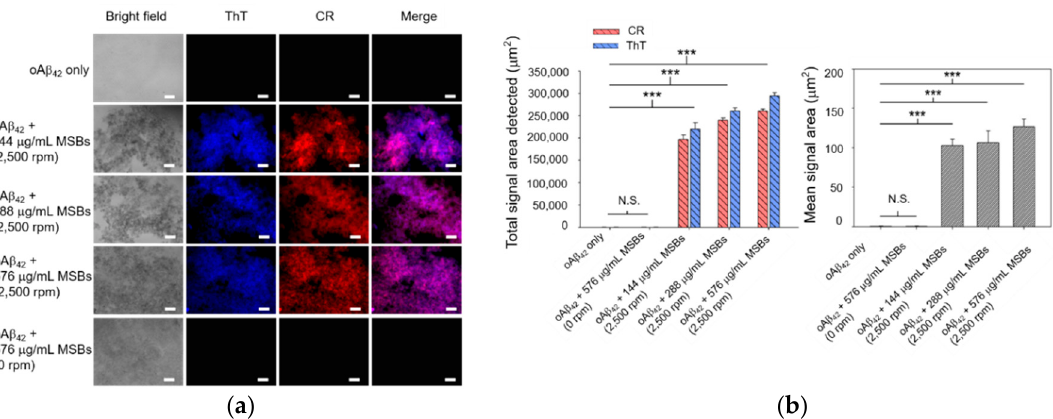
Figure 3. Capture of oA β 42 into mpA β 42 by magnetic stirring with MSBs. ( a ) Fluorescence images of oA β 42 (20 µ M) treated with magnetic stirring as a function of the concentration of MSBs at 2500 rpm for 20 min ( n = 10). Scale bar: 100 µ m. ( b ) The total and mean signal areas detected from the A β 42 aggregation induced by magnetic stirring with MSBs were included. *** p < 0.005 and N.S. p > 0.05. Error bars represent mean ± s.d. ( n = 10).